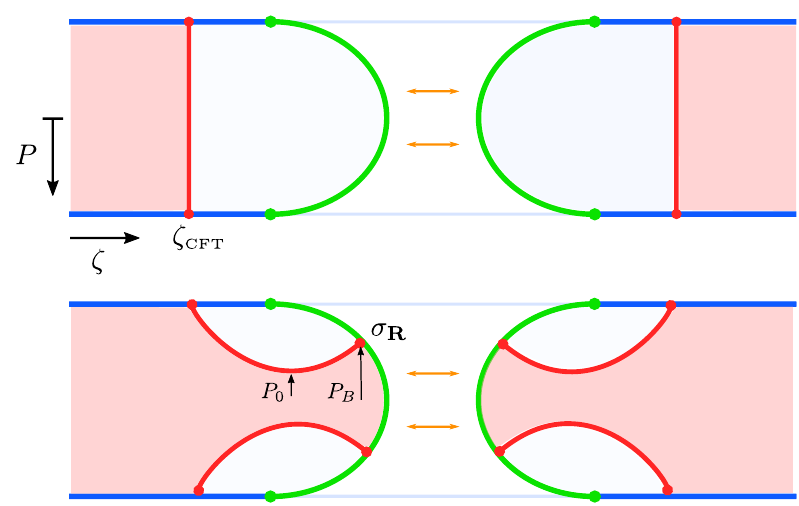
Figure 8 . Sketch of (cid:12)xed time slices of our symmetric setup, showing the two possible con(cid:12)gu- rations. The shaded red region corresponds to the entanglement wedge. The connected solution contains an island on the brane, where gravity is